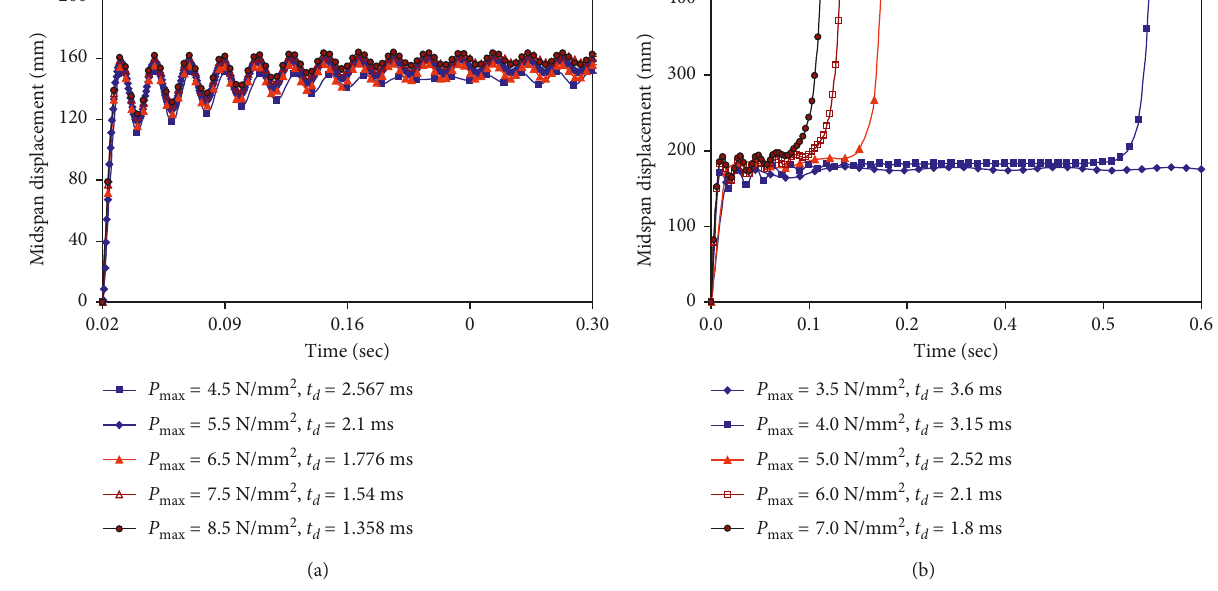
24 subjected to constant values of blast impulses with ×